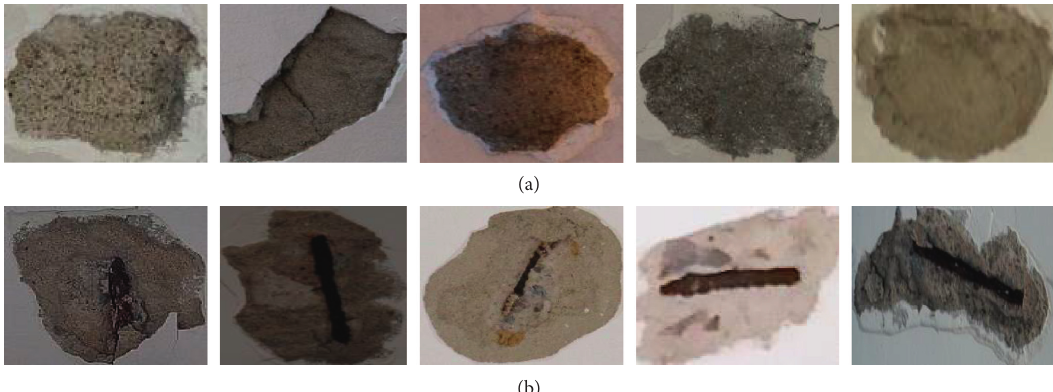
Figure 5: Demonstration of the collected image samples: (a) class label − 1 (shallow spall) and (b) class label +1 (deep